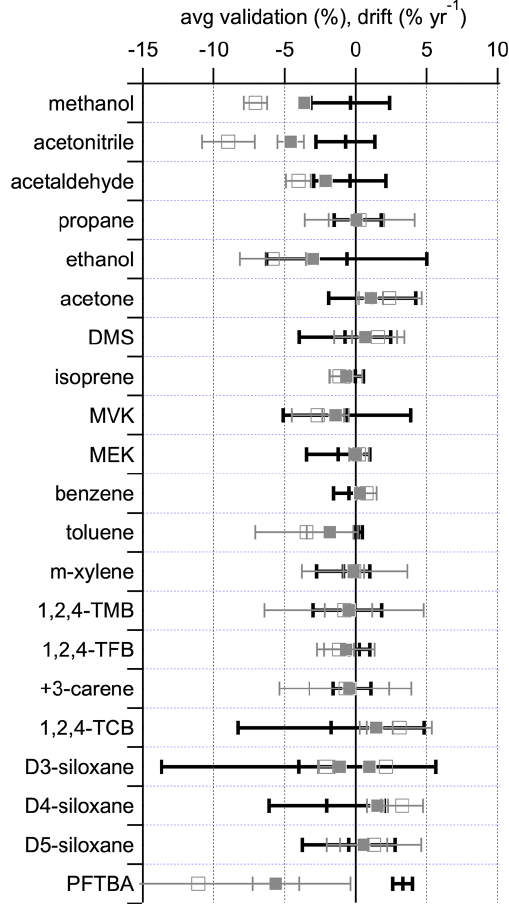
Figure 4. Comparison of 1-year (filled grey squares) and 2-year (open grey squares) drift rates, calculated from the data in Table 3, with the average validation data (black bars) taken from Fig. 2. For D3-siloxane there are two data points for the drift corresponding to the two regressions shown in Table 3. The error bars represent the associated expanded uncertainties, representing the 95% confi- dence